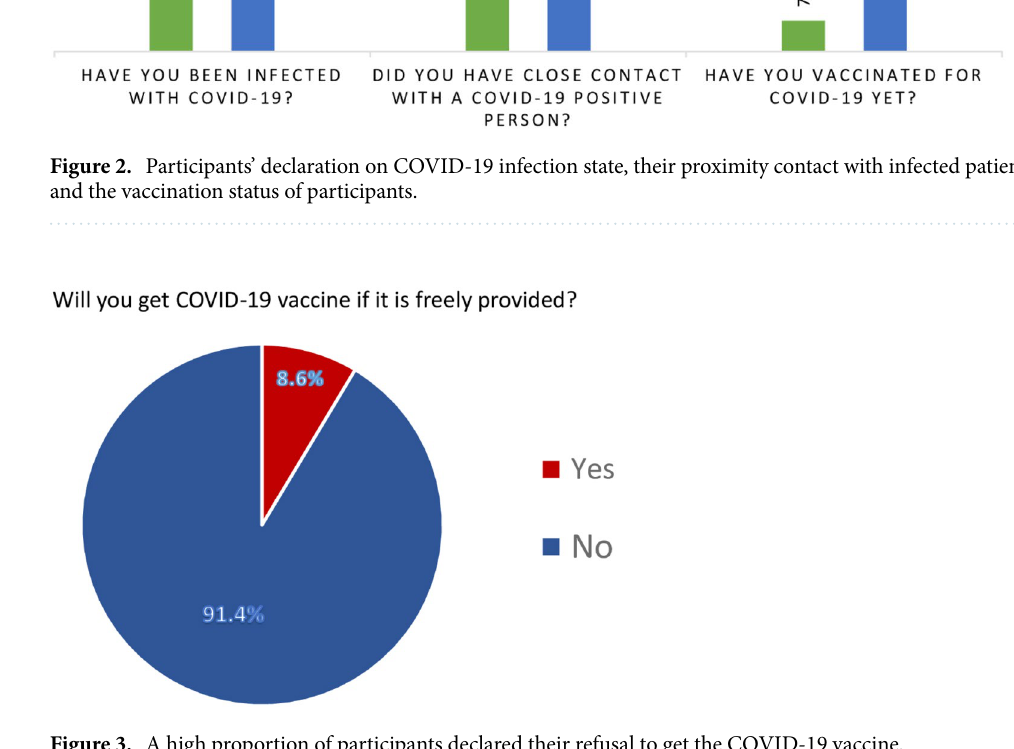
Figure 3. A high proportion of participants declared their refusal to get the COVID-19